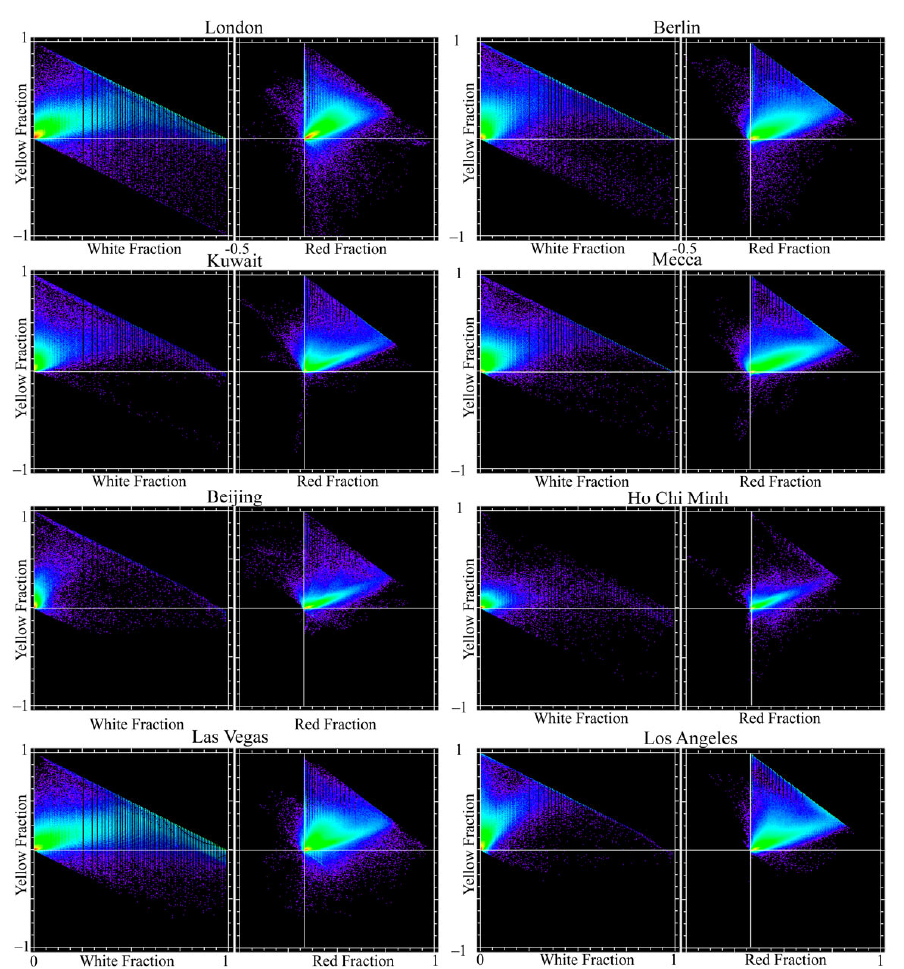
Figure 8. WYR fraction spaces for 8 contrasting lightscapes. The white–yellow projections show varying degrees of saturation on the binary mixing line related to varying exposures of different photographs. Regardless of exposure, all distributions are strongly skewed toward dimmer lights (near the origin), with distinct continua extending to a warm spectrum orange near the red endmember on the yellow–red projection.